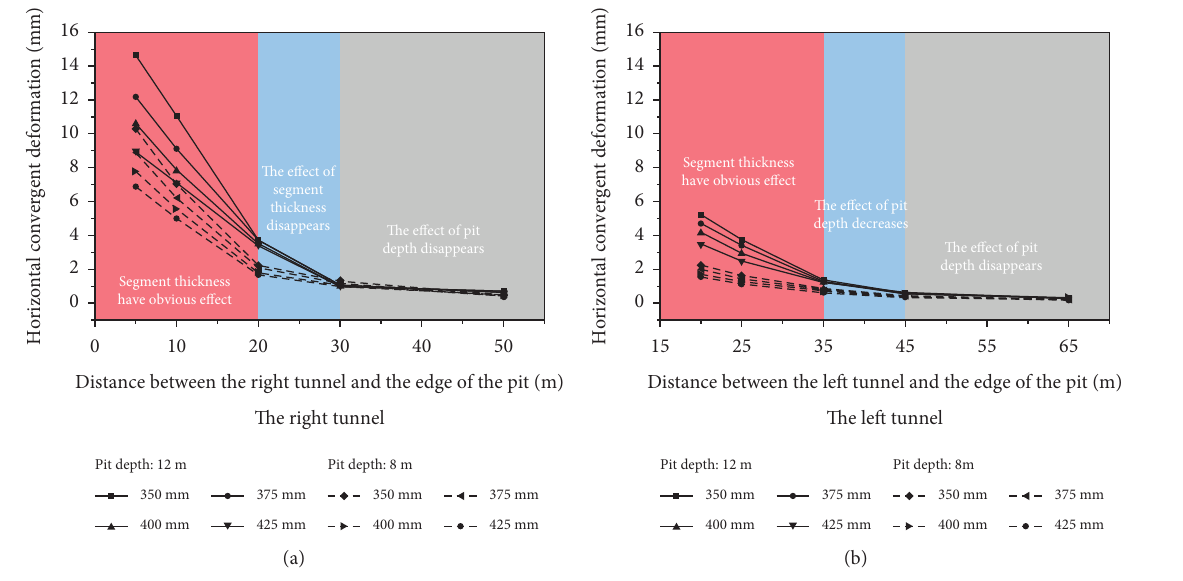
Figure 7: Convergent deformation of tunnel with different segment thickness under varied pit depth. (a) The right tunnel. (b) The left tunnel.